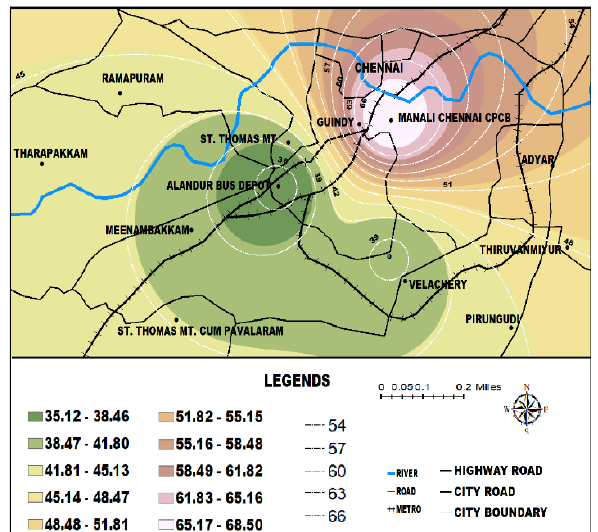
Figure 16. Air quality map of Chennai August monthly average based on PM2.5 (µg/m 3 ).